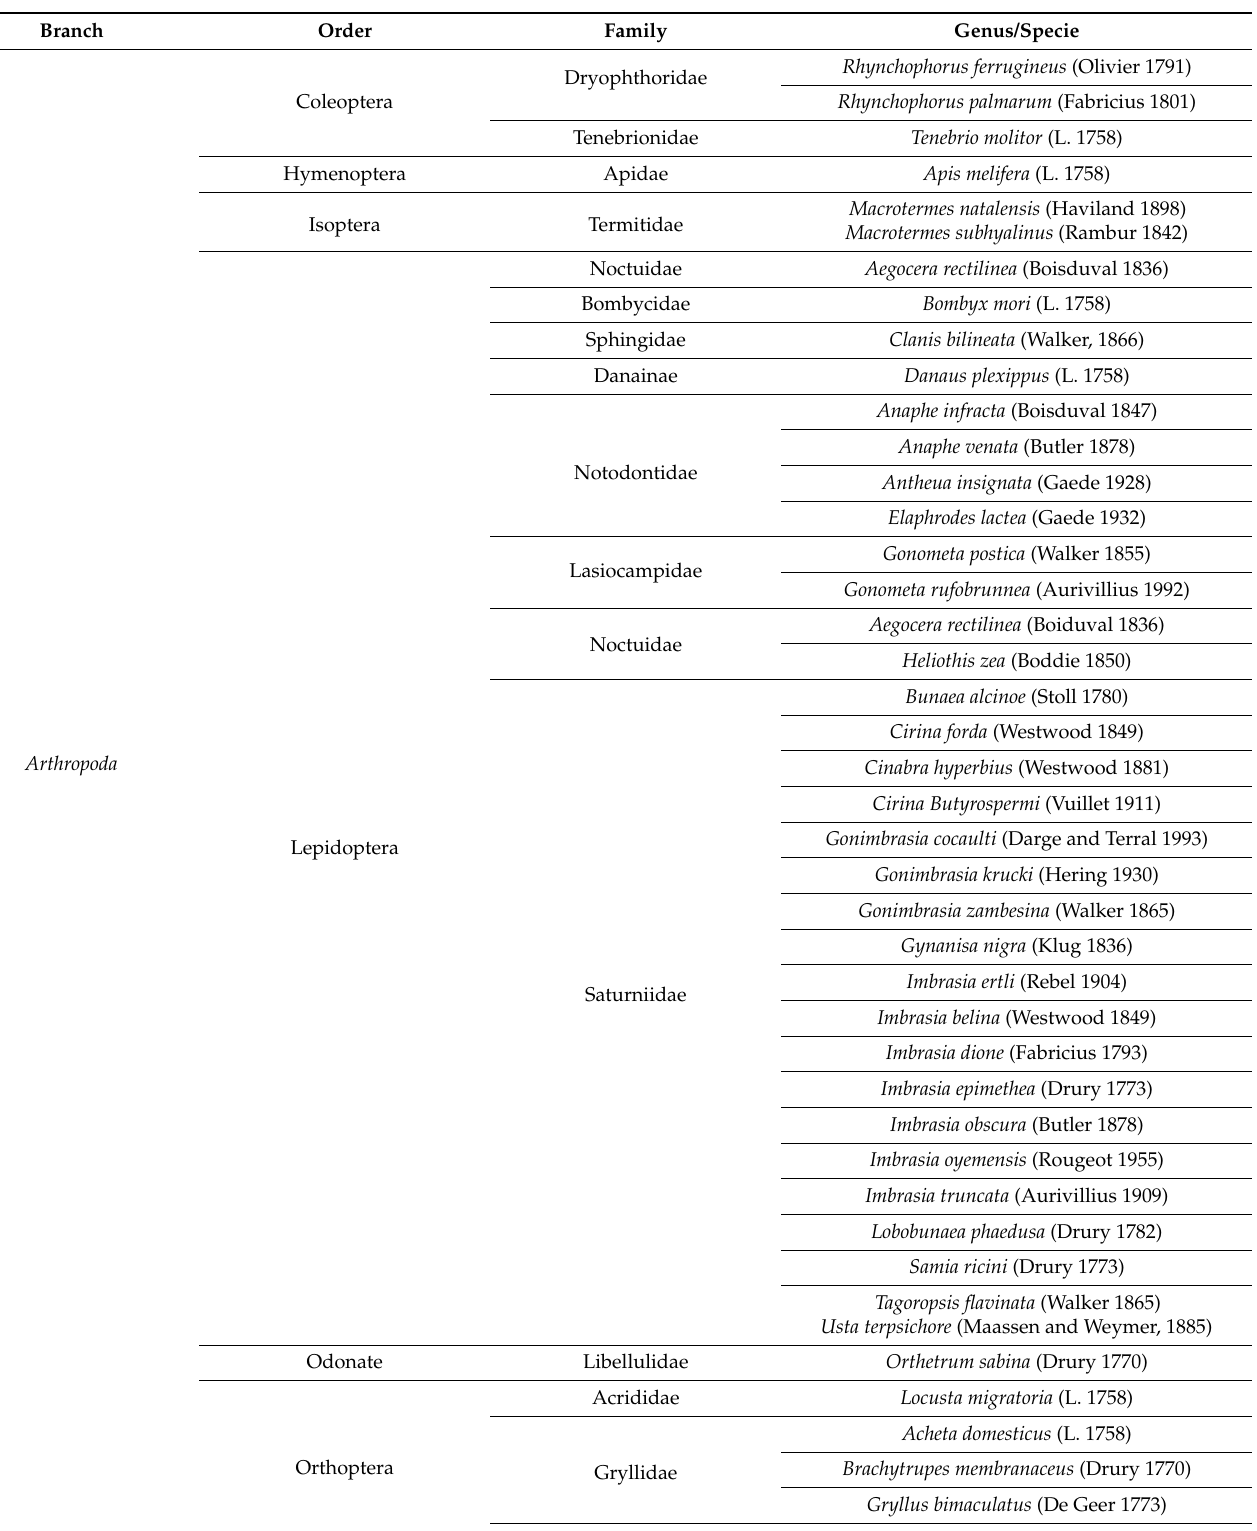
Table 1. Classification of the scientific names mentioned in the